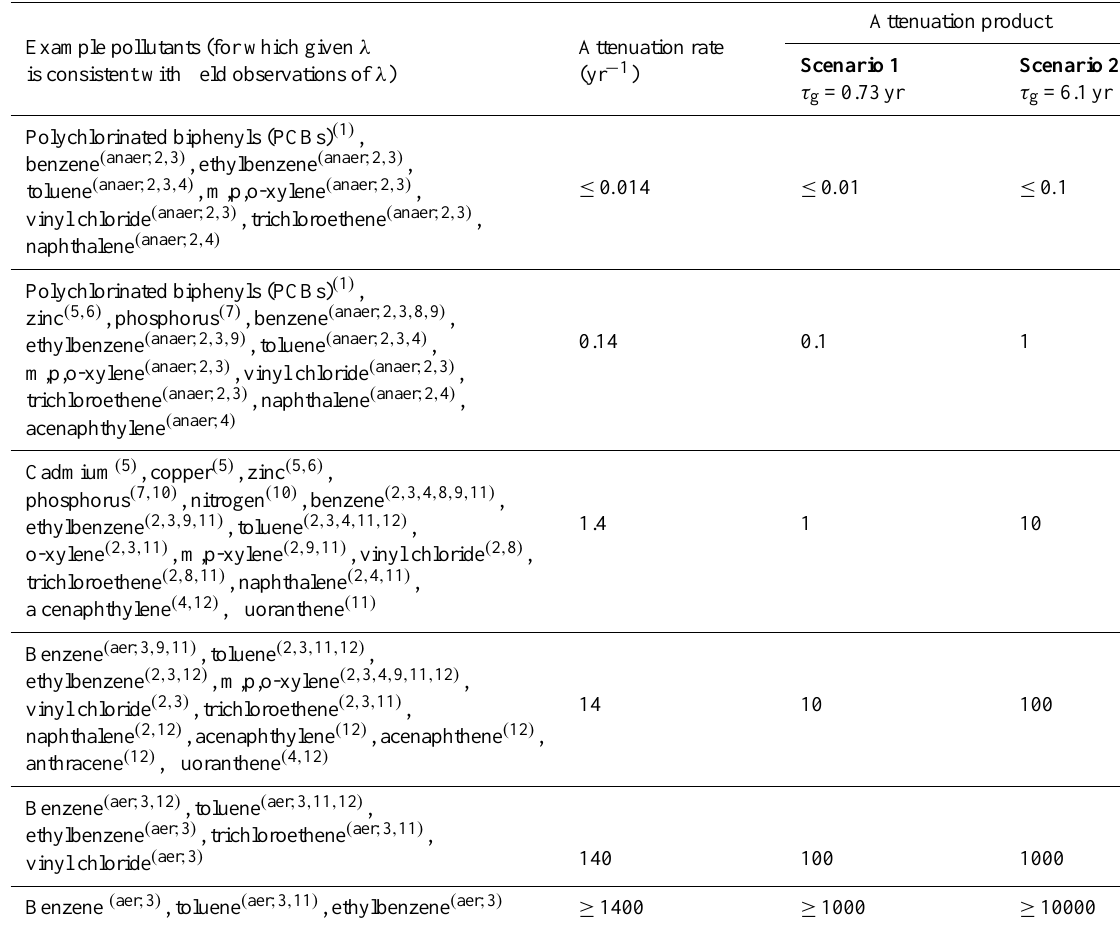
Table 2. Examples of pollutants and nutrients with corresponding estimates of first-order attenuation rate λ from reported field studies, and associated order of magnitude of the attenuation product λτ g for scenarios 1–2 in the Forsmark catchment area. Example pollutants (for which given λ is consistent with field observations of λ )